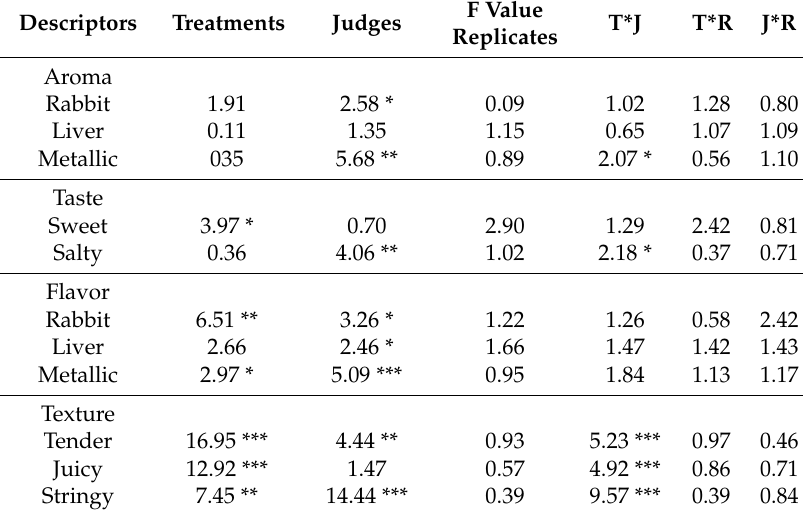
Table 7. The F value and statistical significance of treatments (C, SP1, SP2) and their interaction for sensory descriptors of thigh, where the number of judges, n = 8, and the number of replicates, n =